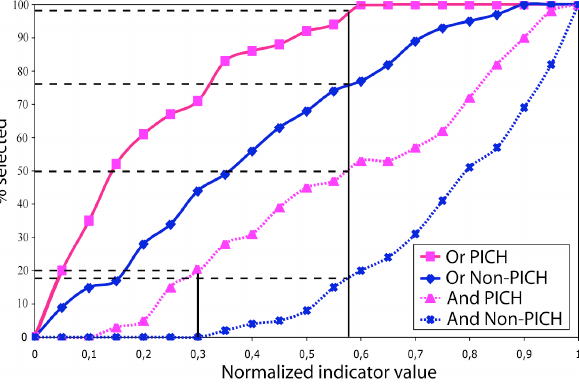
Figure 7. Distribution of the empirical return periods of flooding for the PICH points of the Fig. 7. Distribution of the empirical return periods of flooding for various susceptibility classes. the PICH points of the various susceptibility classes.